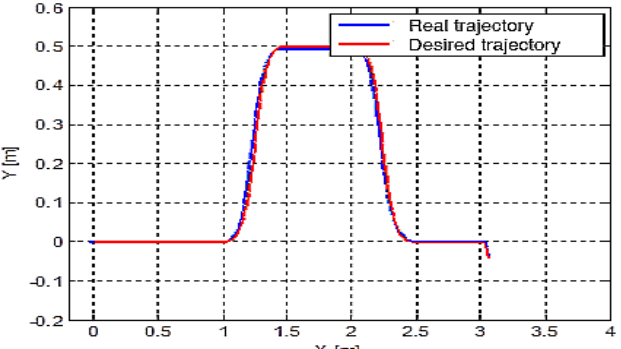
Figure 18. Real and desired trajectory of ARS PeopleBot based on trajectory tracking sliding-mode control.